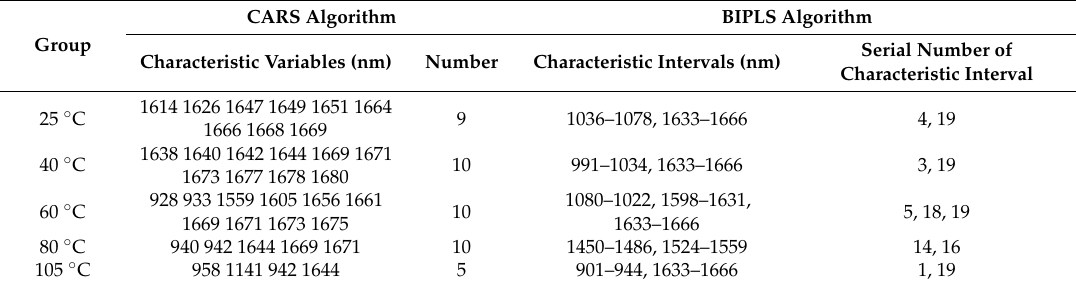
Table 3. The selected characteristic variables, characteristic intervals, and sensitive